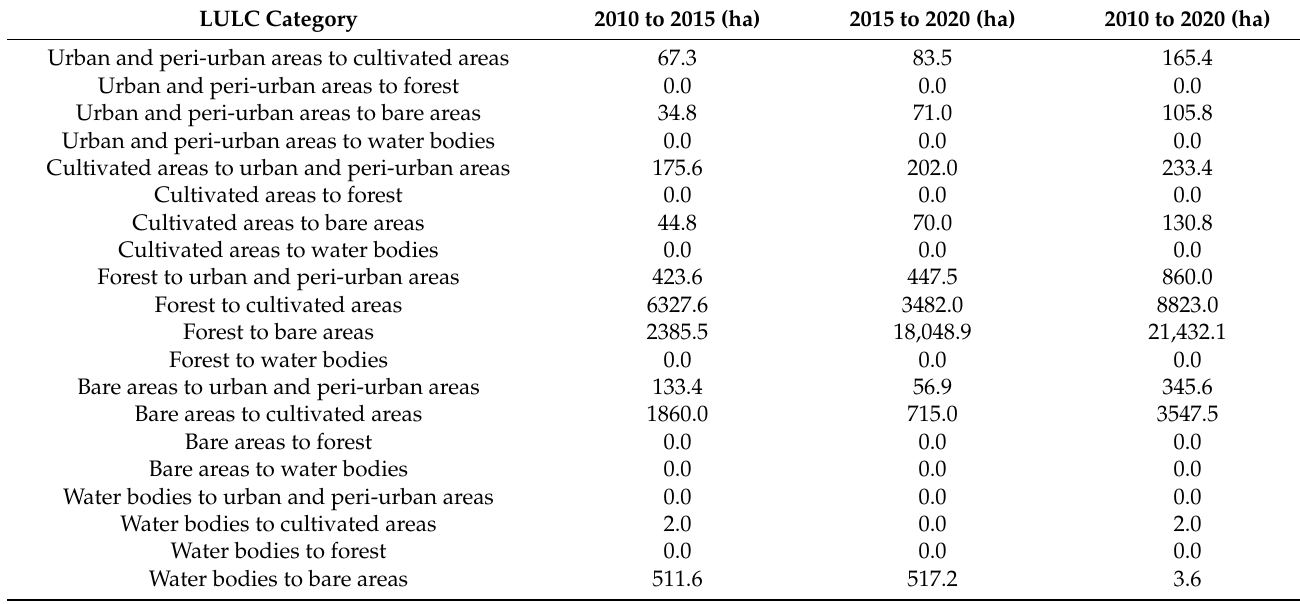
Table 7. Net LULC transitions (in ha) between 2010 and